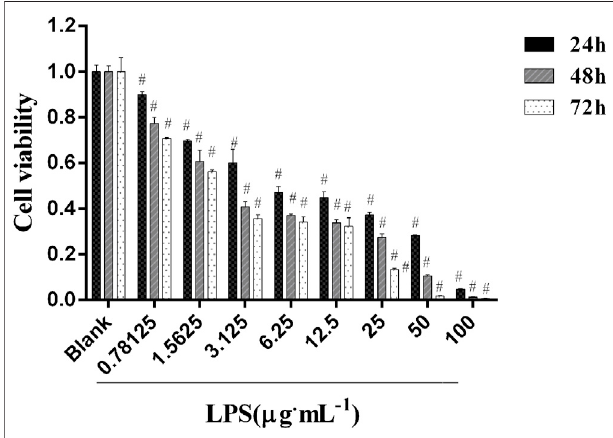
FIGURE3| CellViability after differenttreatmentsofLPS(* p < 0.05, # p < 0.01 versus blank).